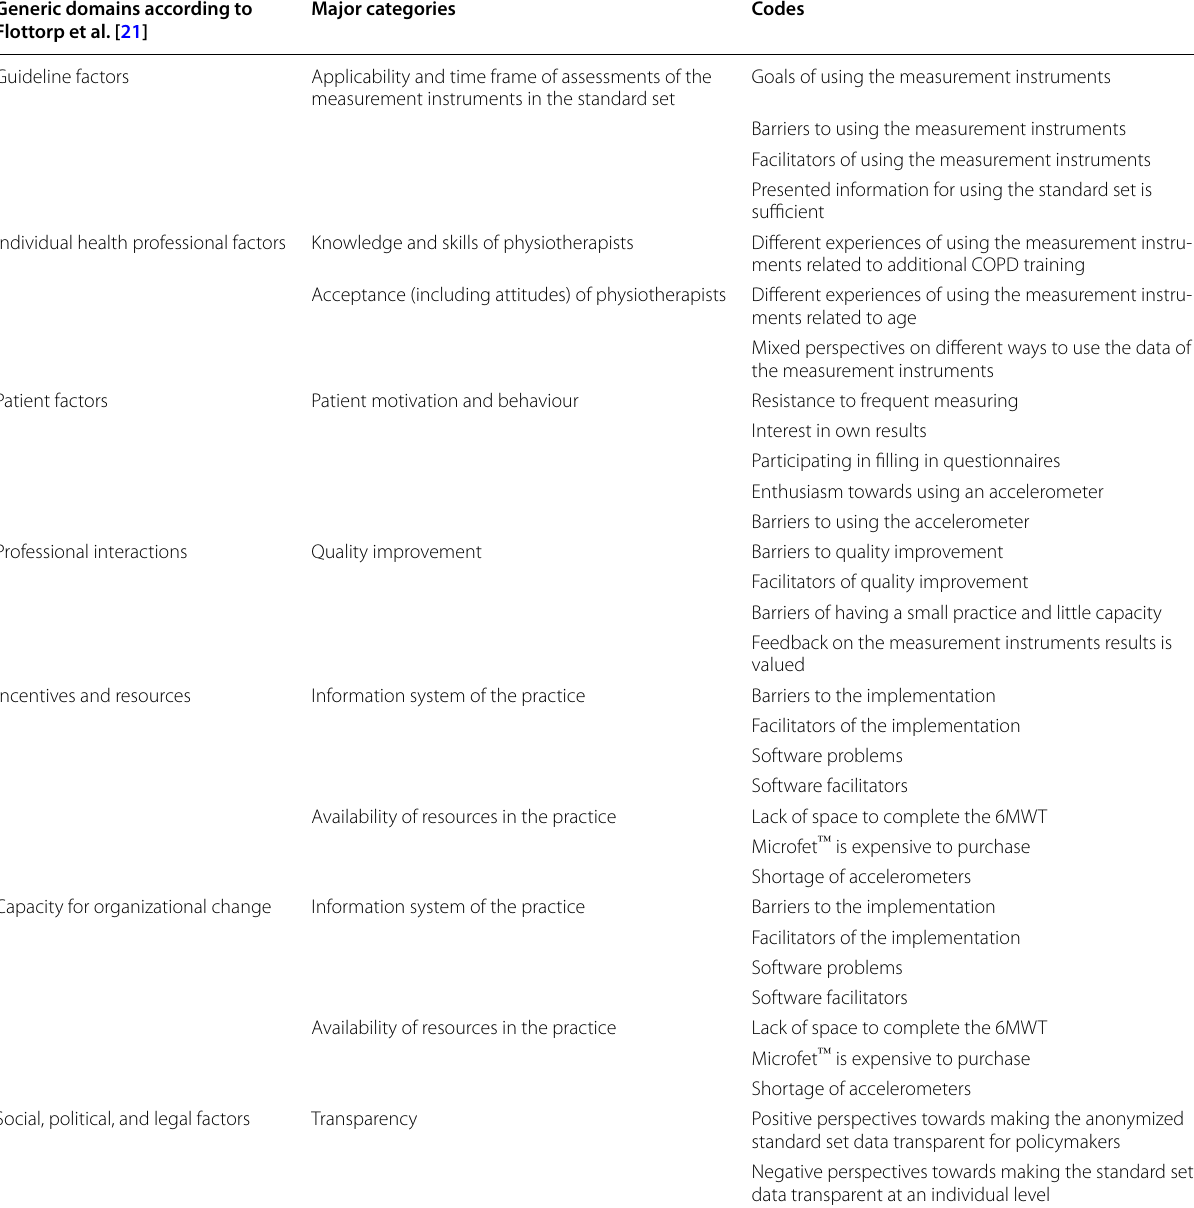
6MWT six-minute walk test, COPD chronic obstructive pulmonary disease